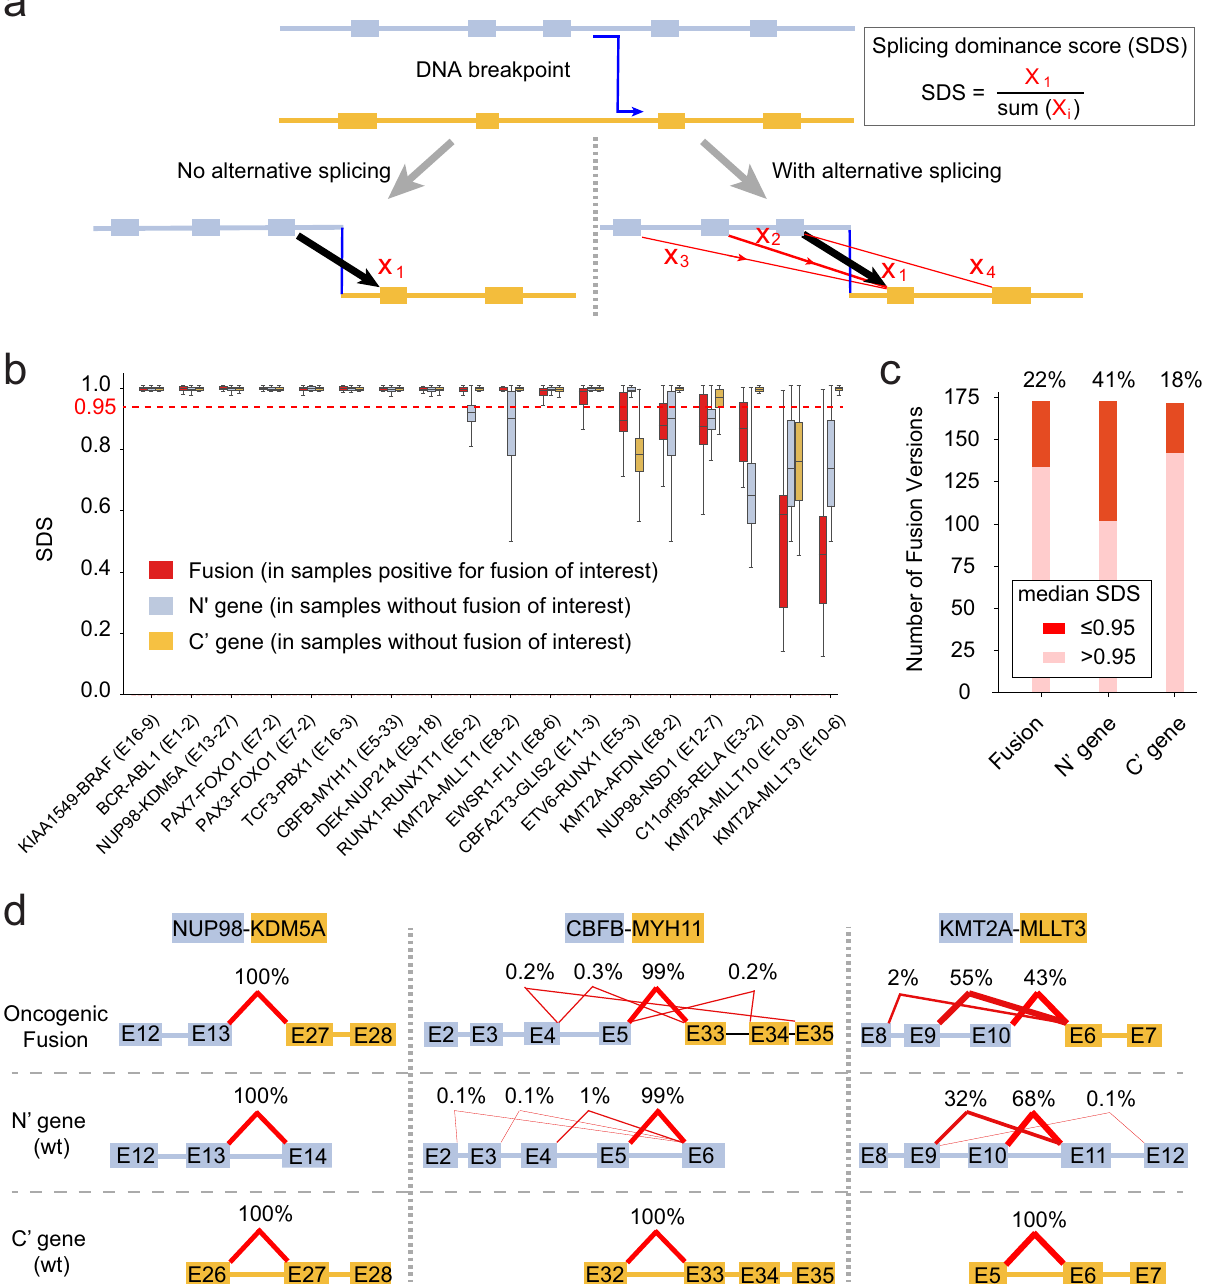
recurrence ≥ 10, wherealternativesplicing (SDS <0.95,reddashed line)is observed in6(33%of18)fusions.Inboxplot,thelower,centerandupperlimitsindicate25th, 50th,and 75thpercentile,respectively. Whiskerisde fi ned using 1.5 IQR. c Asimilar extent of alternative splicing is observed in 183 intronic versions with recurrence >2. d Example oncogenic fusions and splicing patterns. Splicing patterns for wild- typeN ’ (blue)and C ’ genes(orange)are alsopresented.Blackconnectionsindicate canonical splicing, while red connections indicate alternative splicing. Source data are provided in sheets b – d in Source Data fi